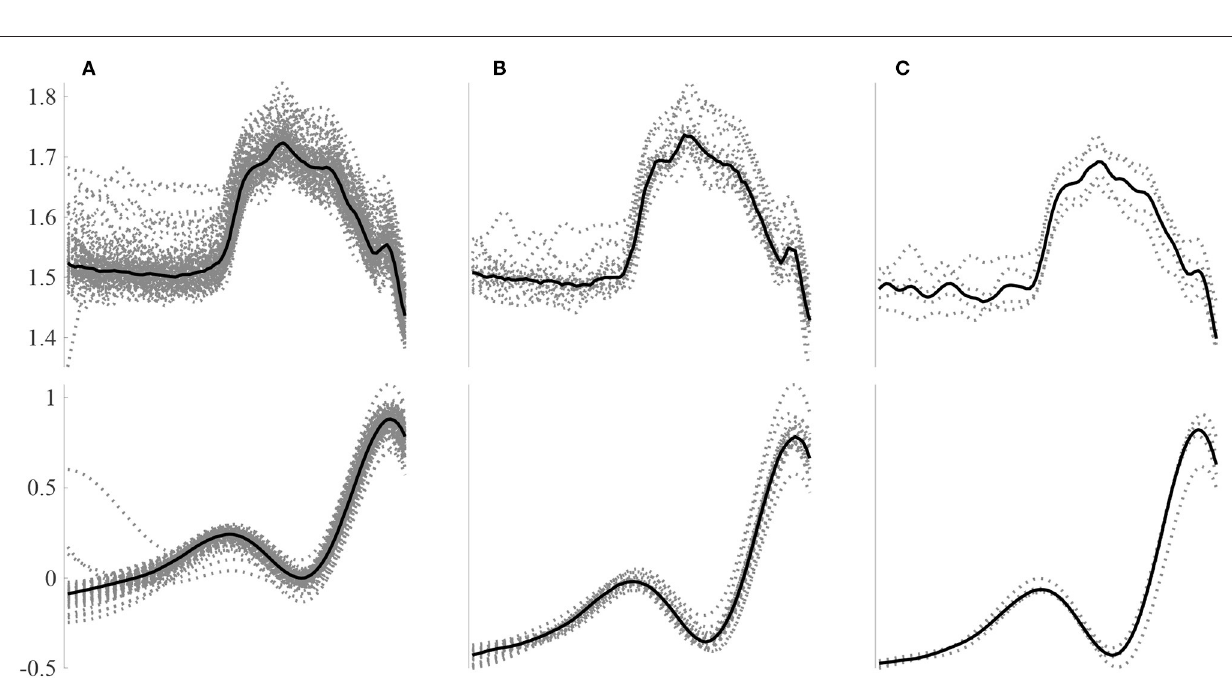
extraction of the ECG segments, an intra-patient template was created using the neighboring beats. Three different templates were computed using 80 (40 prior and 40 posterior the beat